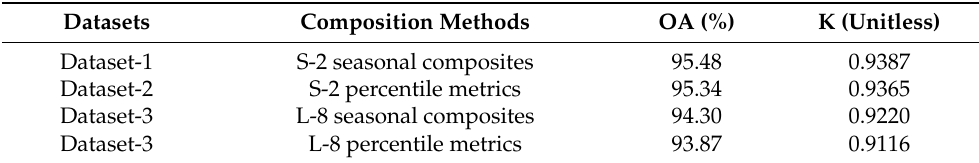
Table 3. Accuracy assessment results of different